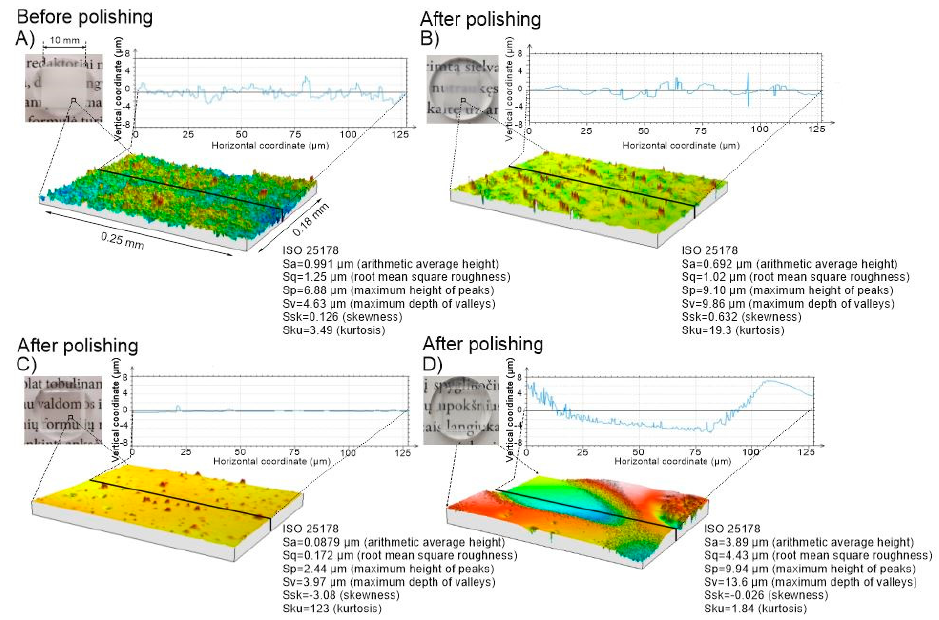
Figure 6. Visual representation of Ra (top left corner). Hydrophilic acrylic after ablation using parameters: P = 30 W, v = 3.65 m / s and dx = 36.5 µ m + 2 additional scans with parameter set